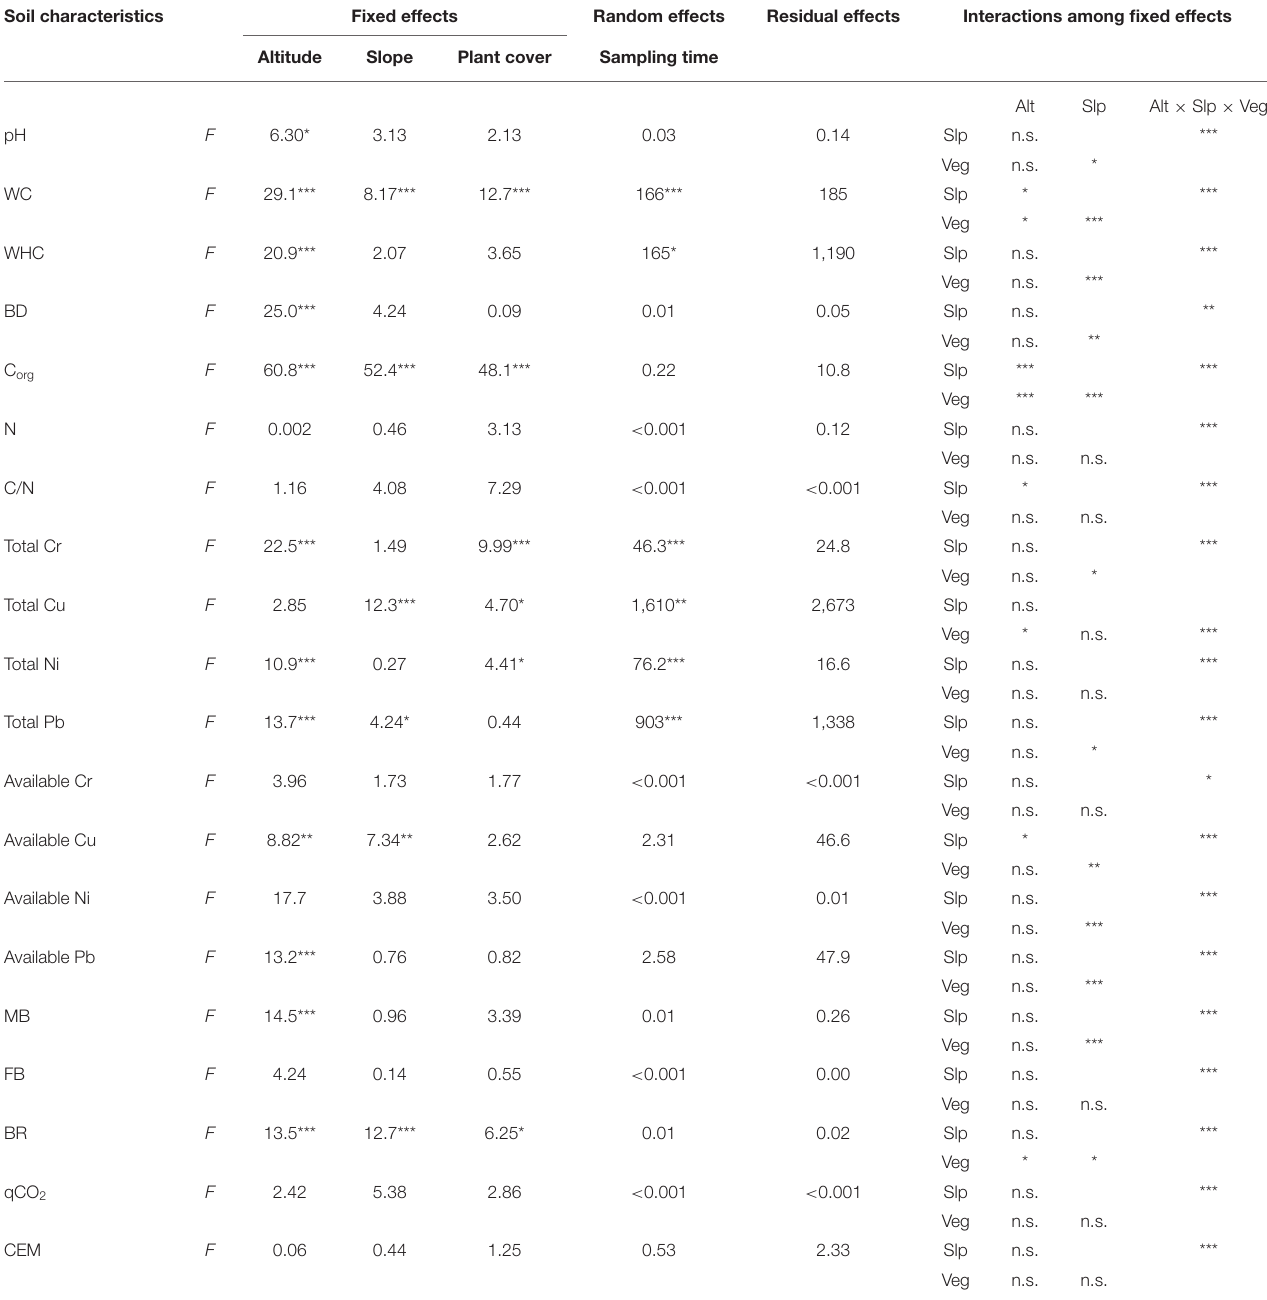
TABLE 3 | Summary of mixed-effect model analyses (F-value: F ) among altitude (Alt), slope exposure (Slp), and plant cover (Veg), as fixed effects, and sampling time, as random effects, on abiotic (pH, water content—WC, water holding capacity—WHC, bulk density—BD, organic carbon content—C org , nitrogen concentration—N, C/N ratio, total concentration and available fraction of Cu, Cr, Ni, and Pb) and biotic (microbial biomass—MB, fungal biomass—FB, basal respiration—BR, metabolic